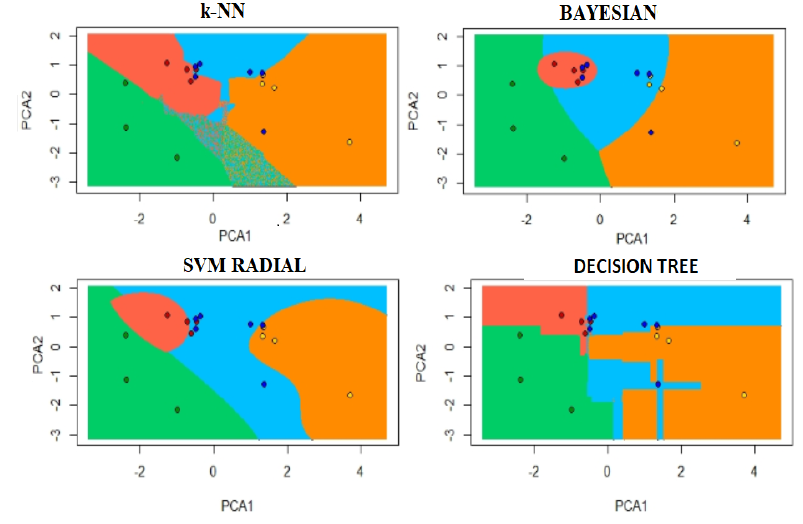
Figure 8. Decision boundaries per label of each classifier. Class 1: green color, class 2: red color, class 3: blue color and class 4: orange color. X axis = Principal component 1. Y axis = Principal component 2.